Question: In one sentence, what is this figure communicating?
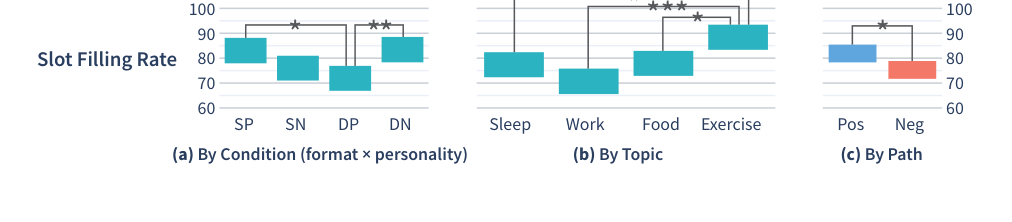
Answer: 95% confidence intervals of slot filling rate by variables with a significant effect: (a) the combination of the information format and personality modifier represented as study condition; (b) topic; and (c) the conversation path. The asterisks with arms indicate significance between the connected categories. (Refer to Appendix A.3 for model details and statistics.)